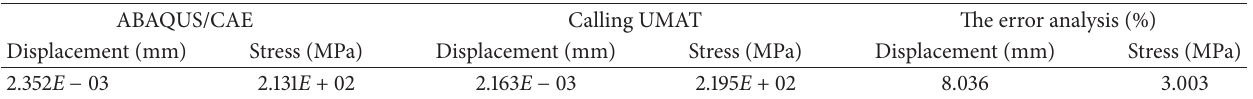
Table 4: The comparison for the results from ABAQUS/CAE and